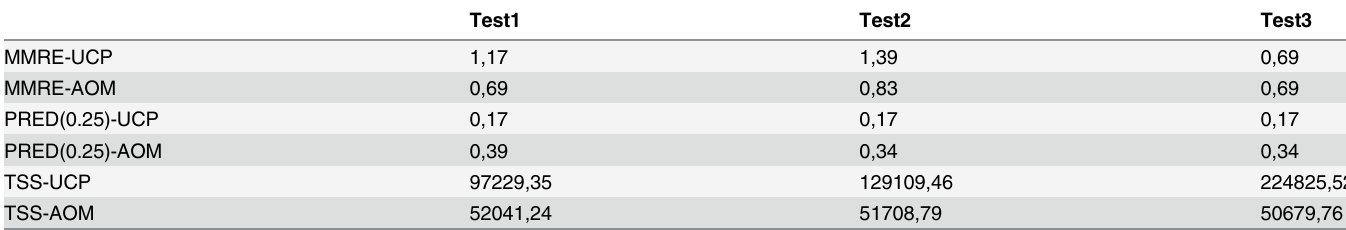
Table 7. Comparison of the Estimation Methods